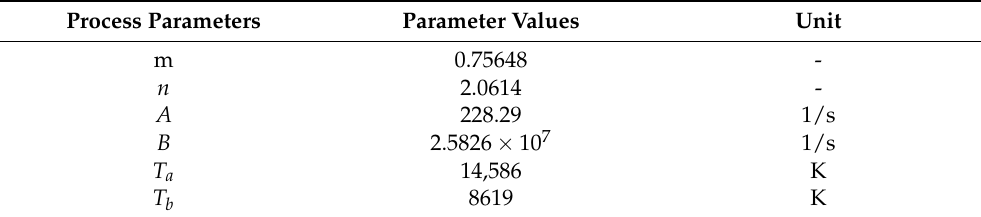
Table 2. Values of the Kamal’s model constants. The constants were measured by a differential scanning calorimeter